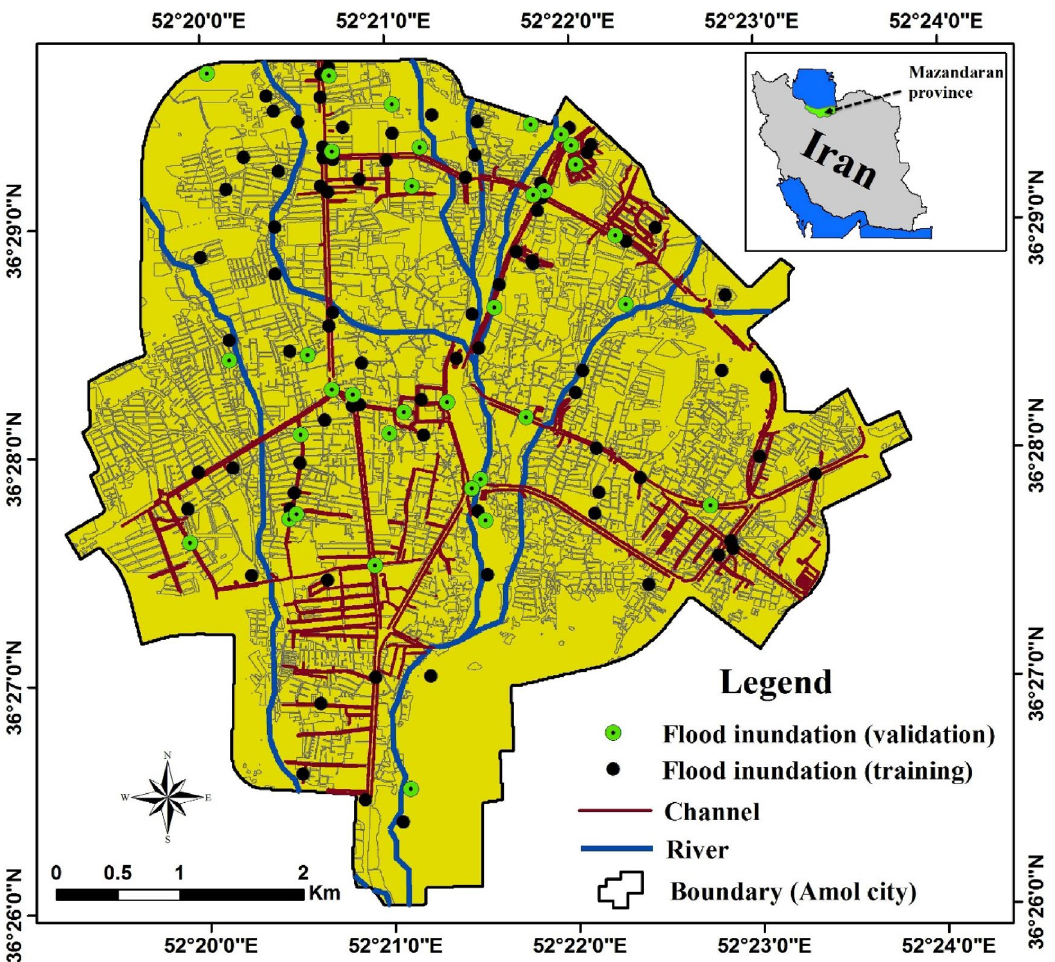
Figure 1. Location of Amol city, Mazandaran province, Iran, and sites affected by past floods. The map was generated using ArcGIS Desktop 10.7.1, https ://deskt op.arcgi